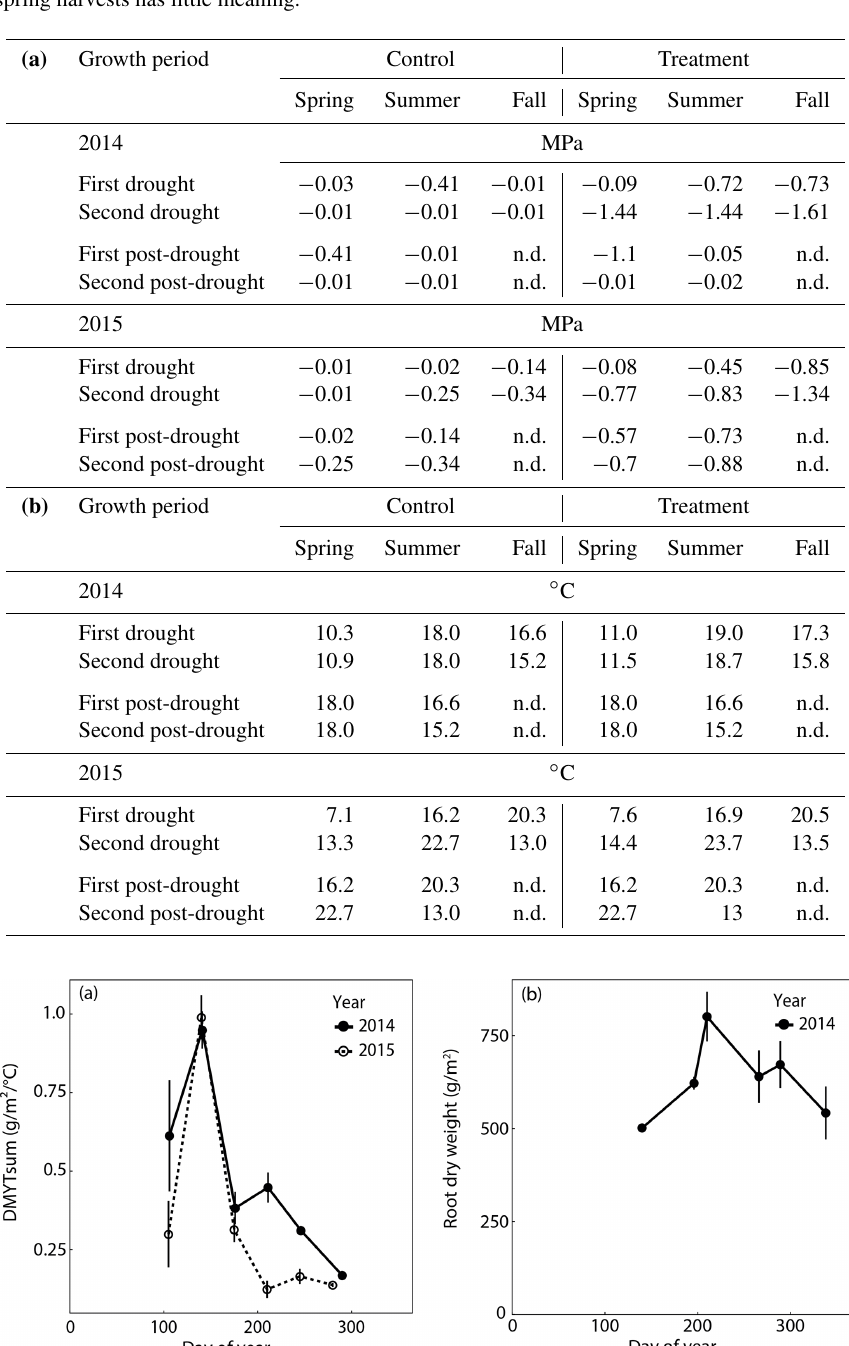
Table 2. (a) Median of soil water potential (MPa) and (b) average air temperature (in ◦ C) during the two growth periods of the drought treatments, the two post-drought growth periods and the corresponding periods of the rain-fed control. Post-drought values of soil water potential and average air temperature are not displayed (n.d.), as calculating these values for the long winter period between the end of the fall treatment and the spring harvests has little meaning.